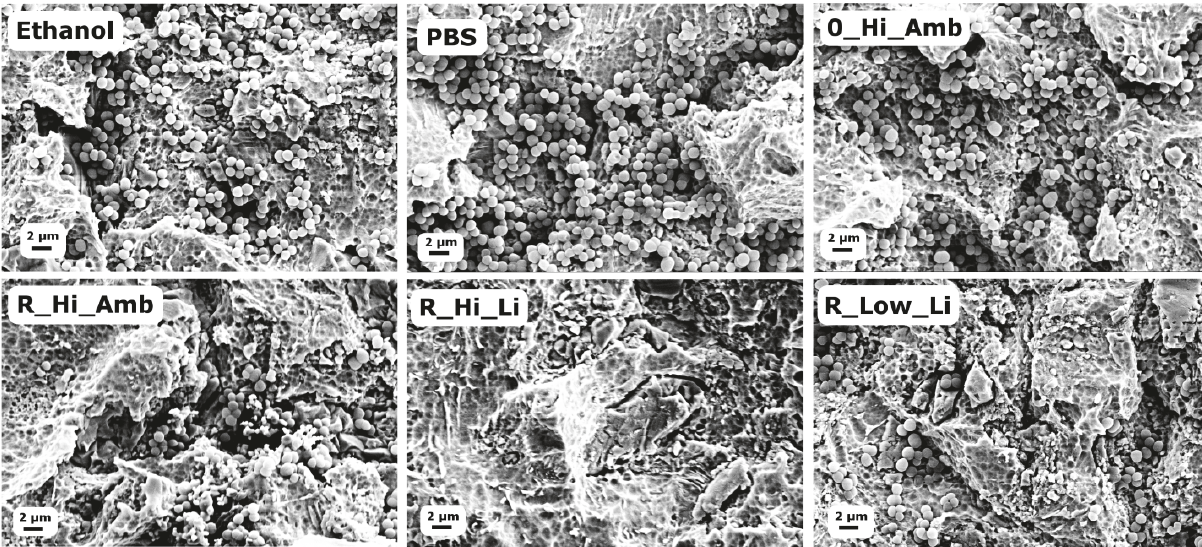
Figure 2: SEM micrographs of S. epidermidis on the Ti surfaces after the different debridement